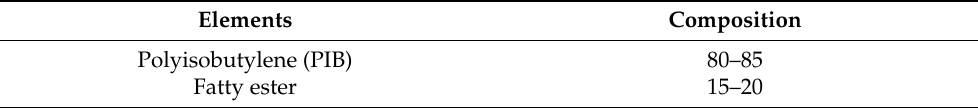
Table 2. Chemical composition of drawing lubricant (wt.%).